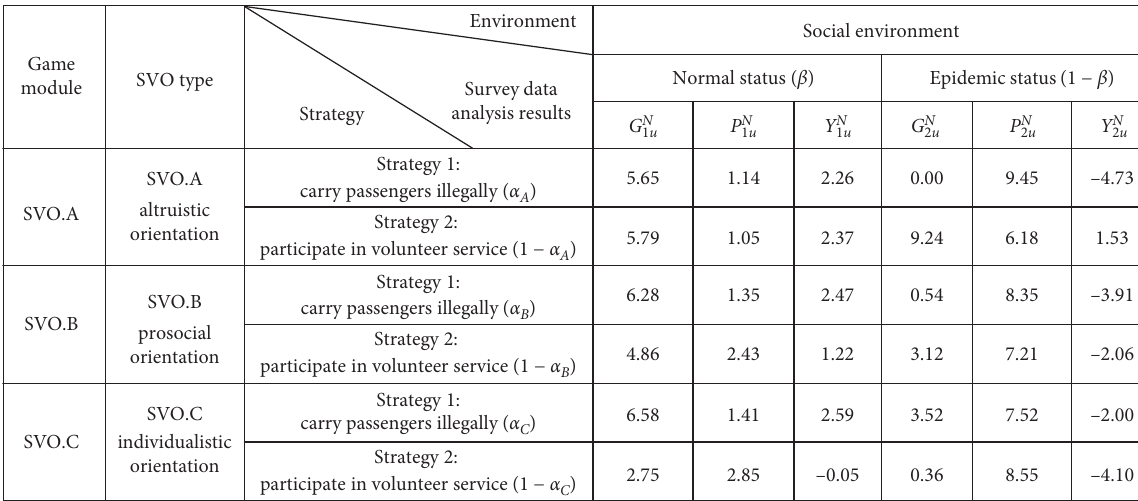
Figure 7: Subjective utility matrix when SVO type is A, B, and C.